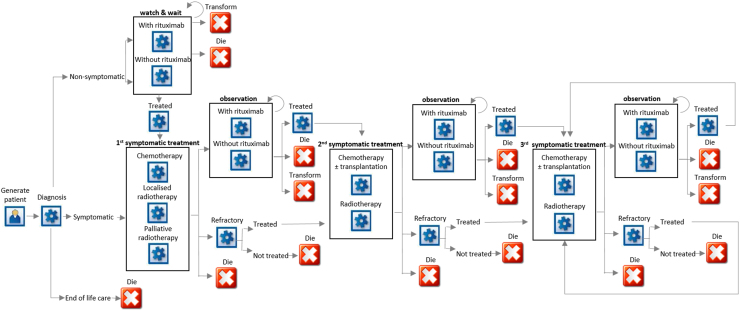
Model structure.